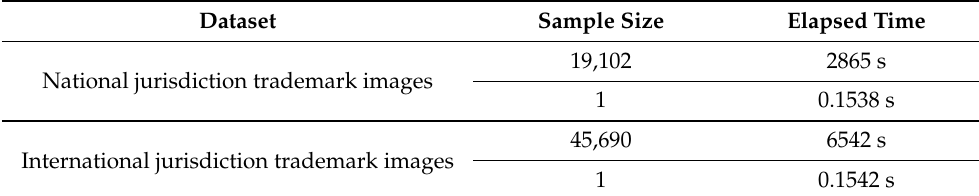
Table 1. Average algorithm execution